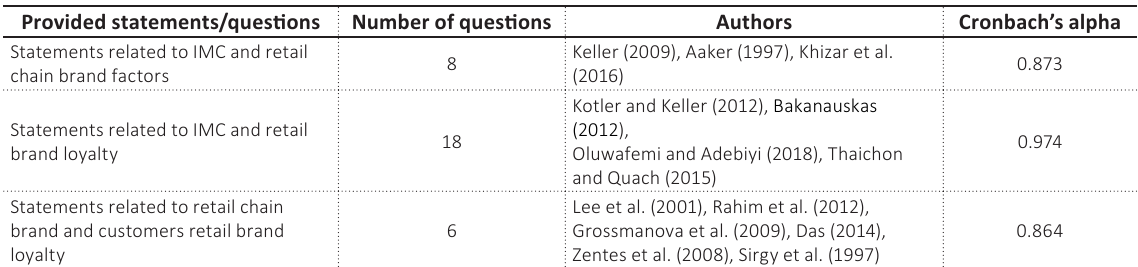
Table 2. Provided statements according to other scientific research by the authors and reliability of the questionnaire